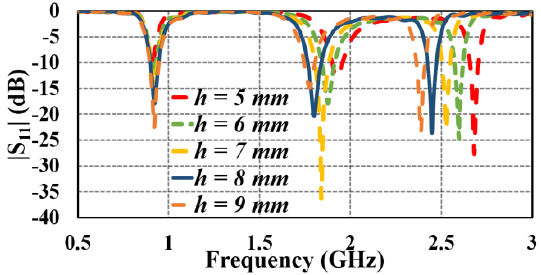
Figure 5: |S 11 | dB variation versus frequency for different gap between main patch and parasitic patch ( g ).